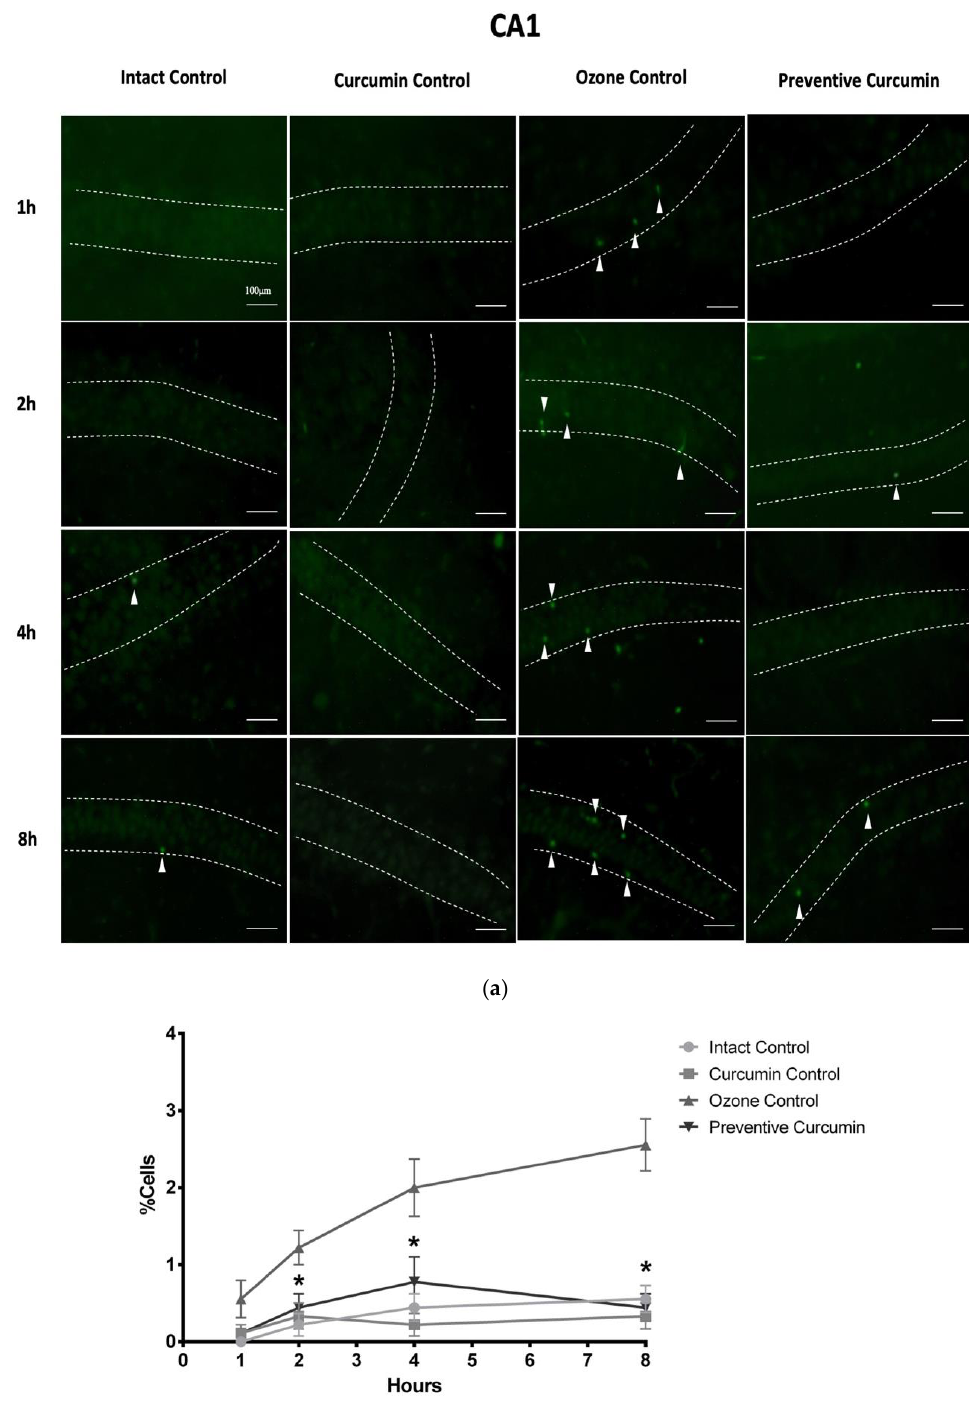
Figure 3. Effect of CUR on hippocampal neurodegeneration after short-term O3 exposure (Table S3). CA1 region was evaluated by the Fluoro-Jade C stain. ( a ) The panel shows representative images of brain sections at different exposure times in experimental groups ( n = 5) showing positive cells (green fluorescence), indicated with white arrowheads, dashed lines indicate the CA1 area. ( b ) The comparison of the degenerative cell percentage at each exposure time in the experimental groups is shown; results are expressed as mean values ± SE, and the asterisk indicates a statistical difference between the preventive curcumin and ozone control groups ( p < 0.05) at 2, 4, and 8